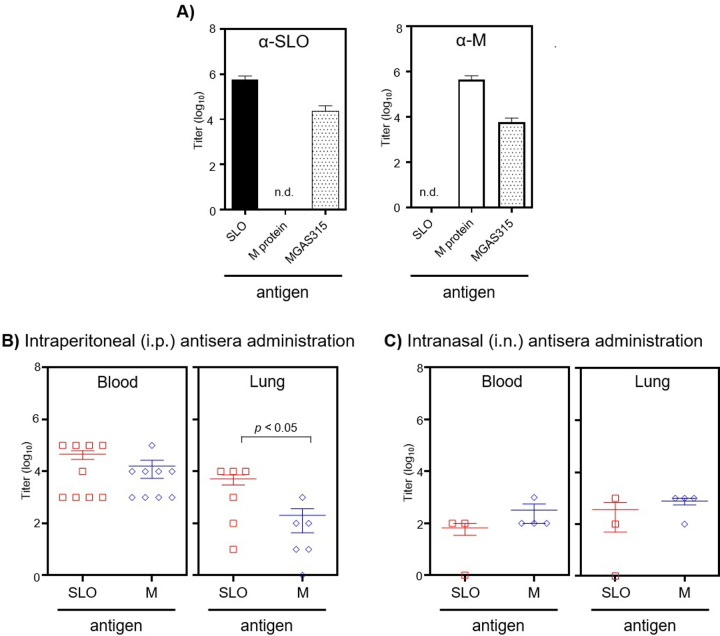
Antisera against SLO or the M protein bound to purified antigen and to immobilized GAS strain MGAS315.(A). The titers were determined with ELISA. Data shown are the means ± sem from 4 to 5 independent experiments. n.d. indicates antibody binding was not detected; α refers to antisera. ELISA was also used to determine the titers of antibodies specific to SLO (open square) or the M protein (open diamond) in the blood and lungs of mice 24 hours after B) i.p. or C) i.n administration of antisera. The means ± sem from 3 to 9 mice are indicated. Statistical significance was determined with the Student's t-test.